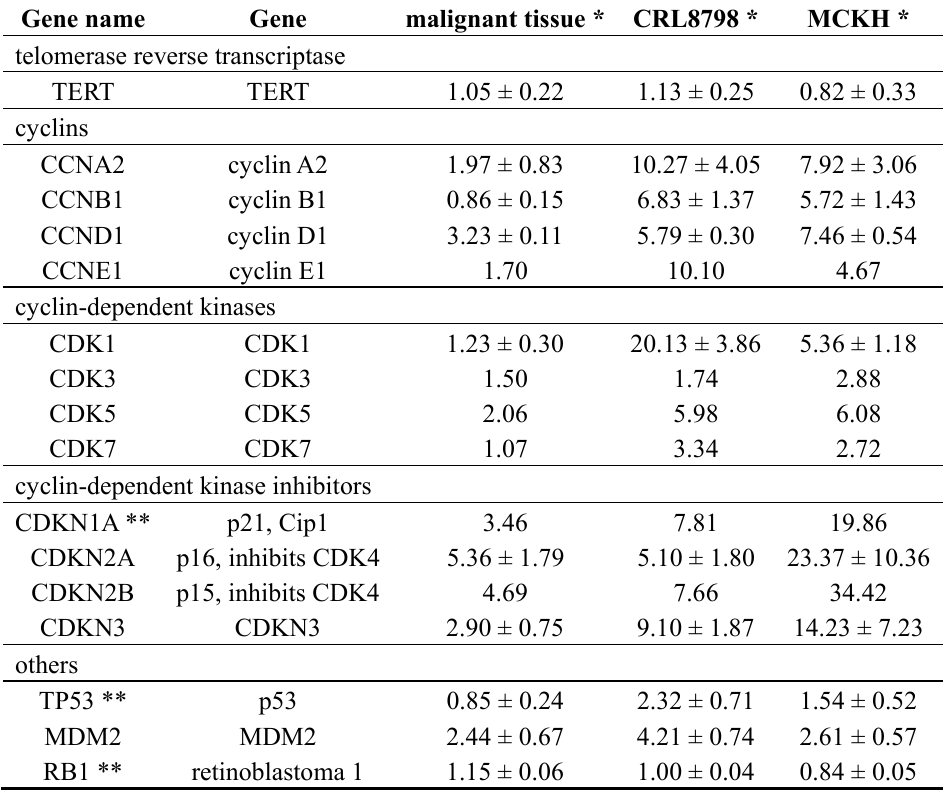
Table 2. Expression profiles of cell-cycle-related genes in MCKH